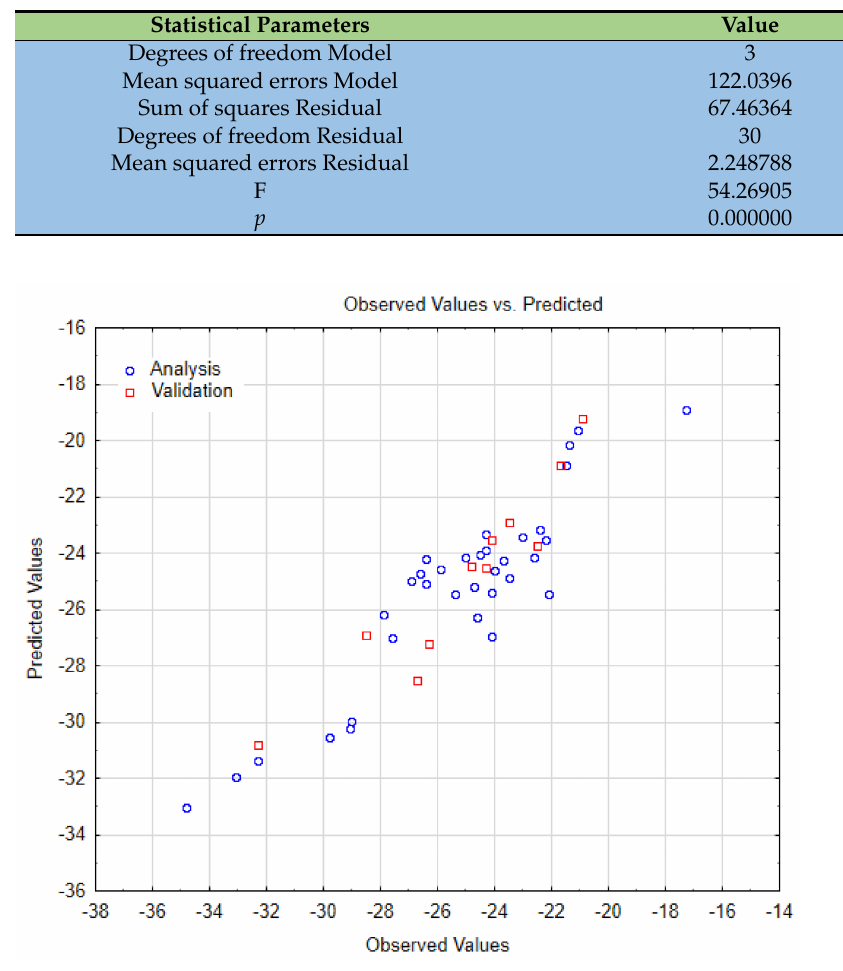
Figure 8. Results of observed versus predicted values obtained for the Nano-QSTR regression model performed for the SWCNT-COOH data.